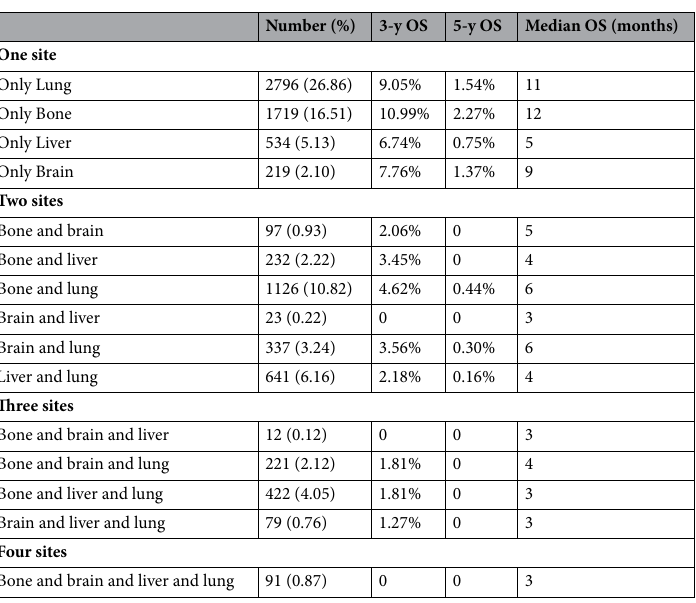
Table 2. Frequencies of combination metastasis and 3, 5-y OS. OS: overall